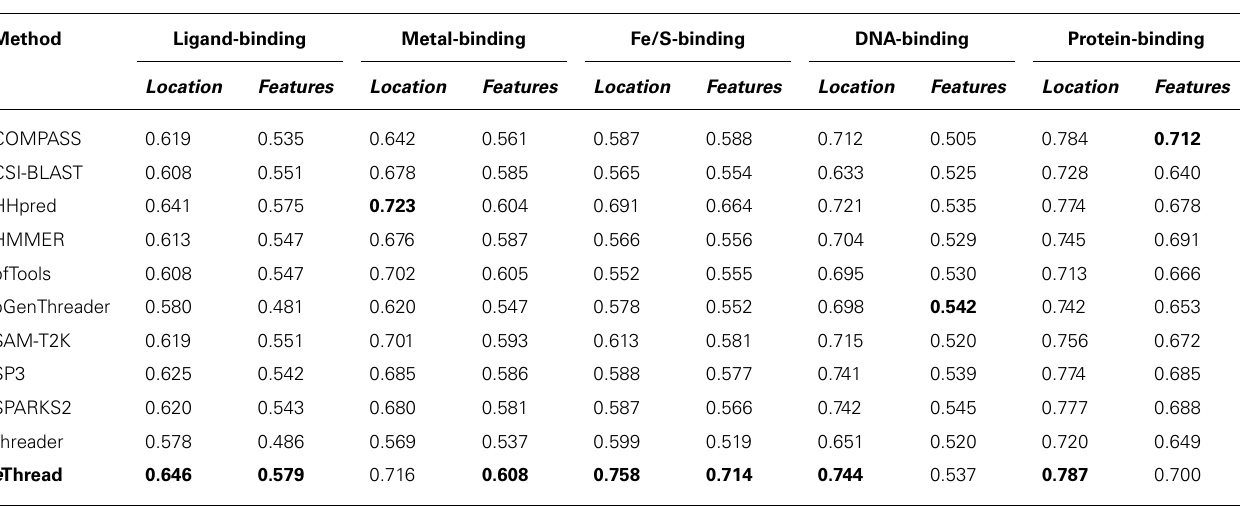
Table 2 | BEDROC scores calculated for individual threading methods compared to that of e